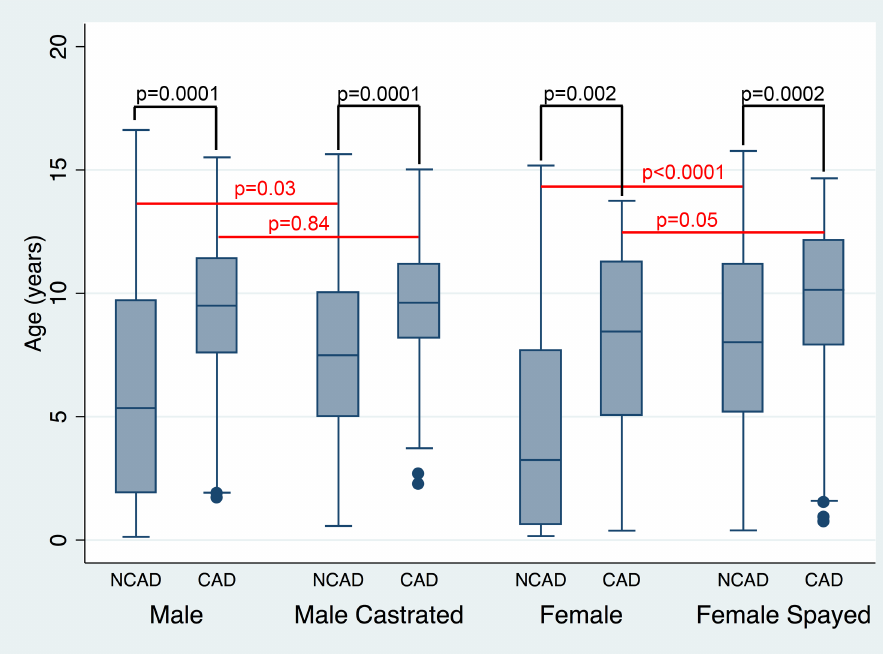
Fig 5. Age of golden retrievers broken out by sex and cause of death. Box and whisker plot showing median age, interquartile range, adjacent values and outliers of golden retriever dogs who underwent a necropsy exam and an attributable or non-attributable death from cancer categorized by sex and spay or neuter status. P values are shown for differences between cancer and non-cancer attributed deaths within each sex category and for differences between sex category within the cancer and non-cancer attributed death groups. NCAD = non-cancer attributable death, CAD = Cancer attributable death.